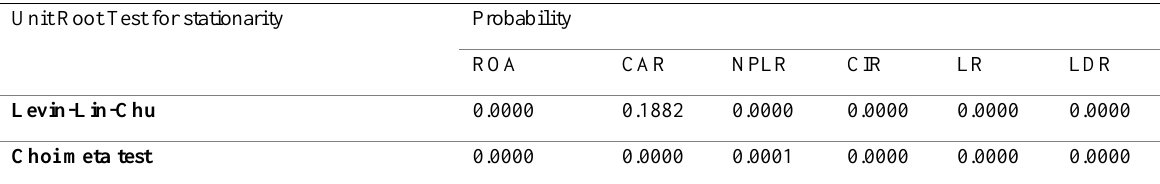
Table 3: Panel Unit Root Test Results for the